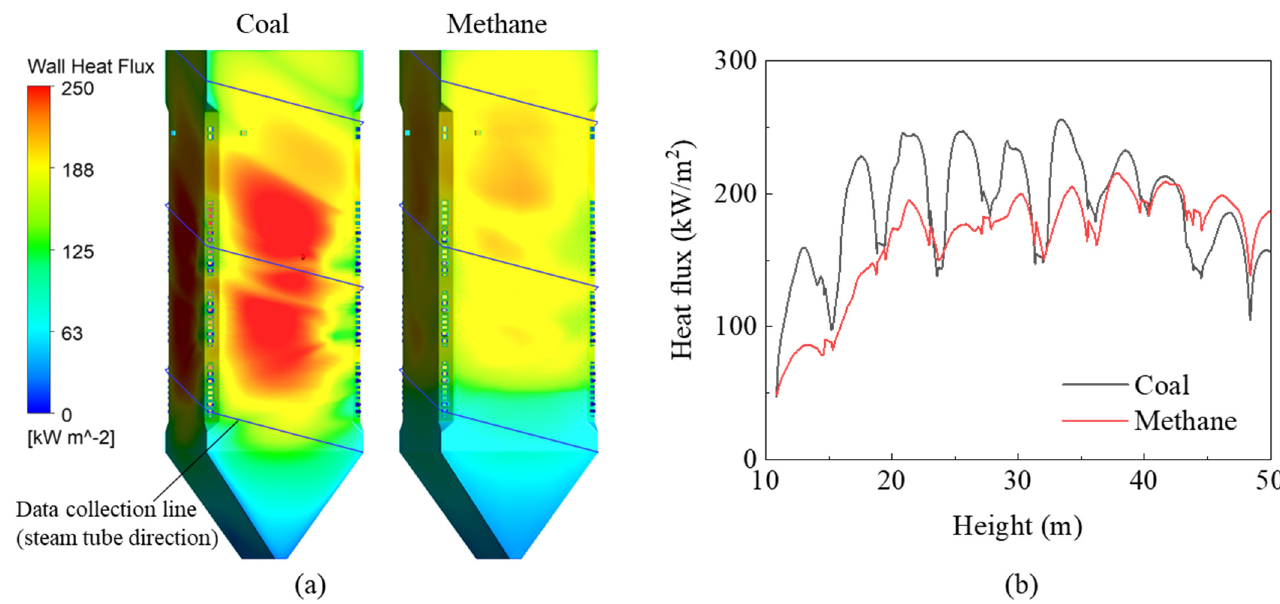
Figure 7. ( a ) Heat flux contours and ( b ) profiles on the data collection line.